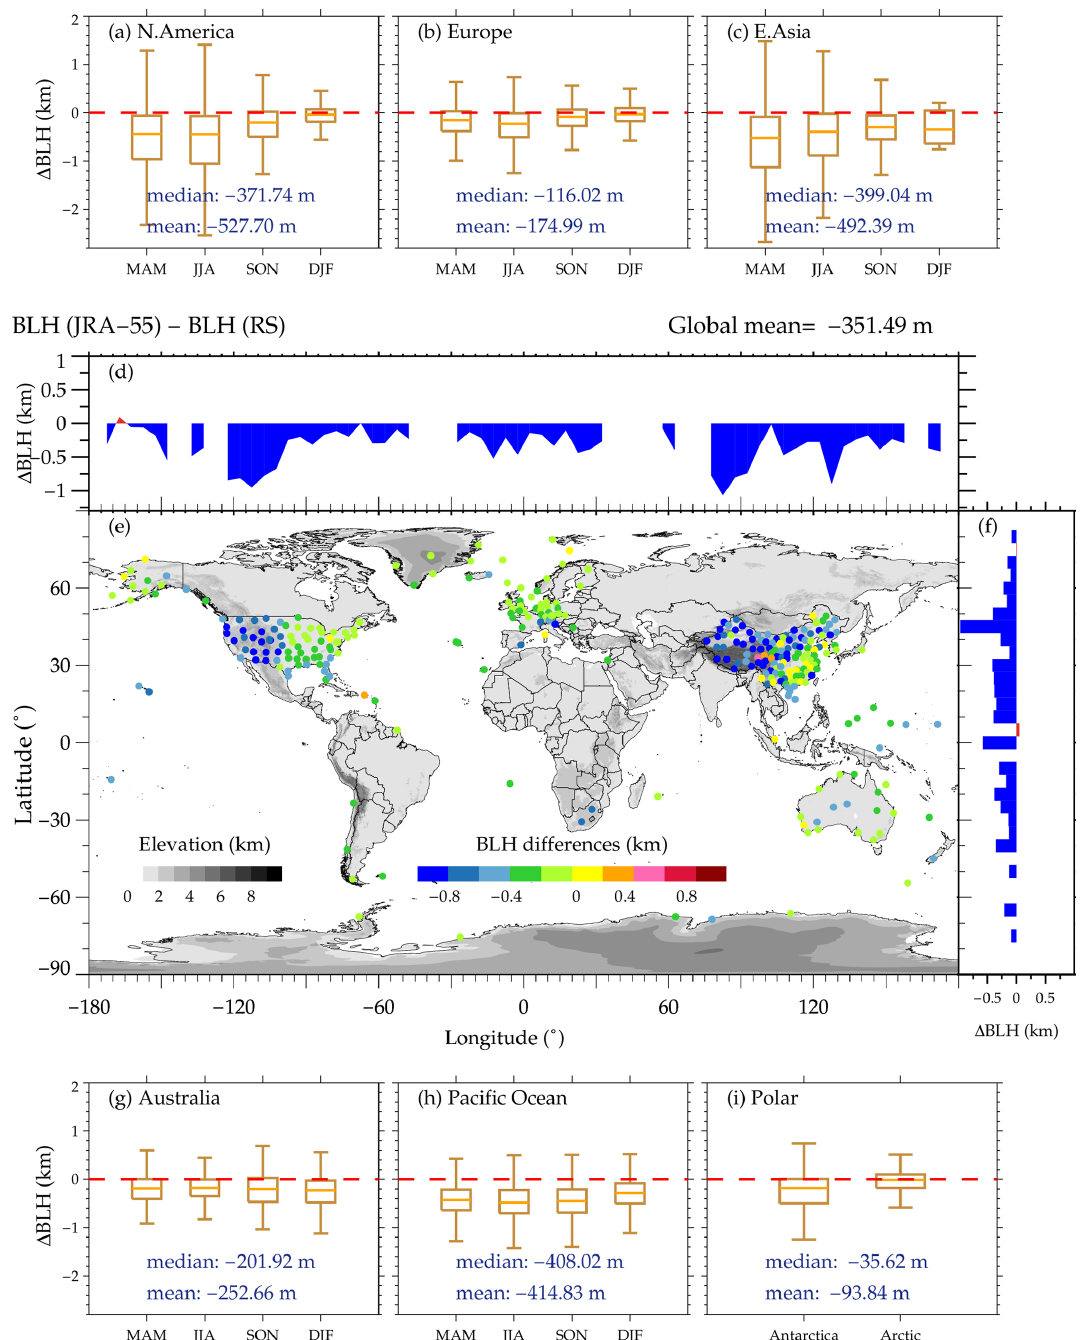
Figure 9. Similar to Fig. 7 but for the differences between JRA-55-derived BLHs and radiosonde-determined BLHs.